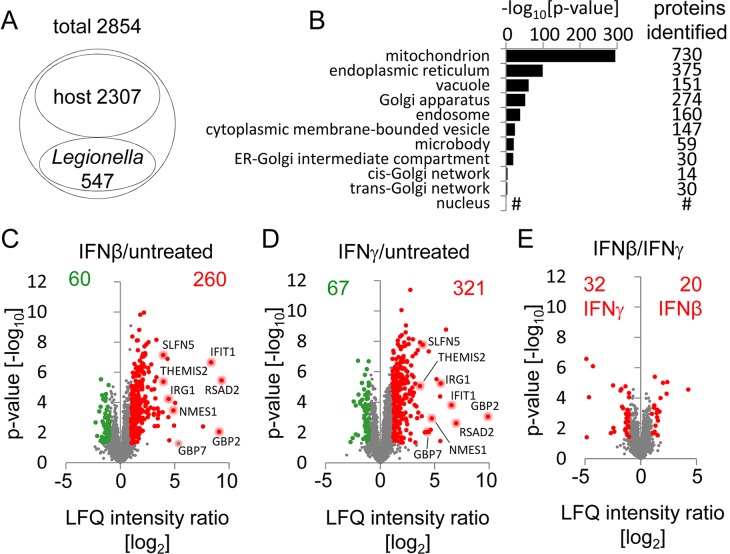
Type I and II IFNs alter the protein composition of LCVs.(A) Proteomic analysis of LCVs isolated 2 h p.i. from untreated BMMs infected with L. pneumophila ΔflaA detected 2854 proteins in all six replicates of which 2307 were identified as host- and 547 as L. pneumophila-derived. (B) GO enrichment analysis for overrepresented cellular components of the host proteins was done and overrepresented child terms of GO:0043231 ‘intracellular membrane-bounded organelle’ were extracted. Depicted are p-values for the indicated GO terms as well as the number of identified proteins annotated with each term; # no p-value for GO term ‘nucleus’ was computed. (C-E) Quantitative proteomic analysis of LCVs isolated 2 h p.i. with L. pneumophila ΔflaA from BMMs left untreated or treated with 50 U/ml IFNβ or IFNγ 16–18 h prior to and during infection. Volcano plots show unchanged proteins (grey) and proteins with a significant higher (red) or lower (green) abundance at LCVs from IFNβ- (C) or IFNγ- (D) treated BMMs compared to untreated cells, and direct comparison of IFNβ- versus IFNγ-treated samples (E). See also S6 Fig for detailed list of top 20 proteins for each condition. Proteomic analysis was done from 6 (untreated), 5 (IFNγ) and 4 (IFNβ) individual LCV isolations.